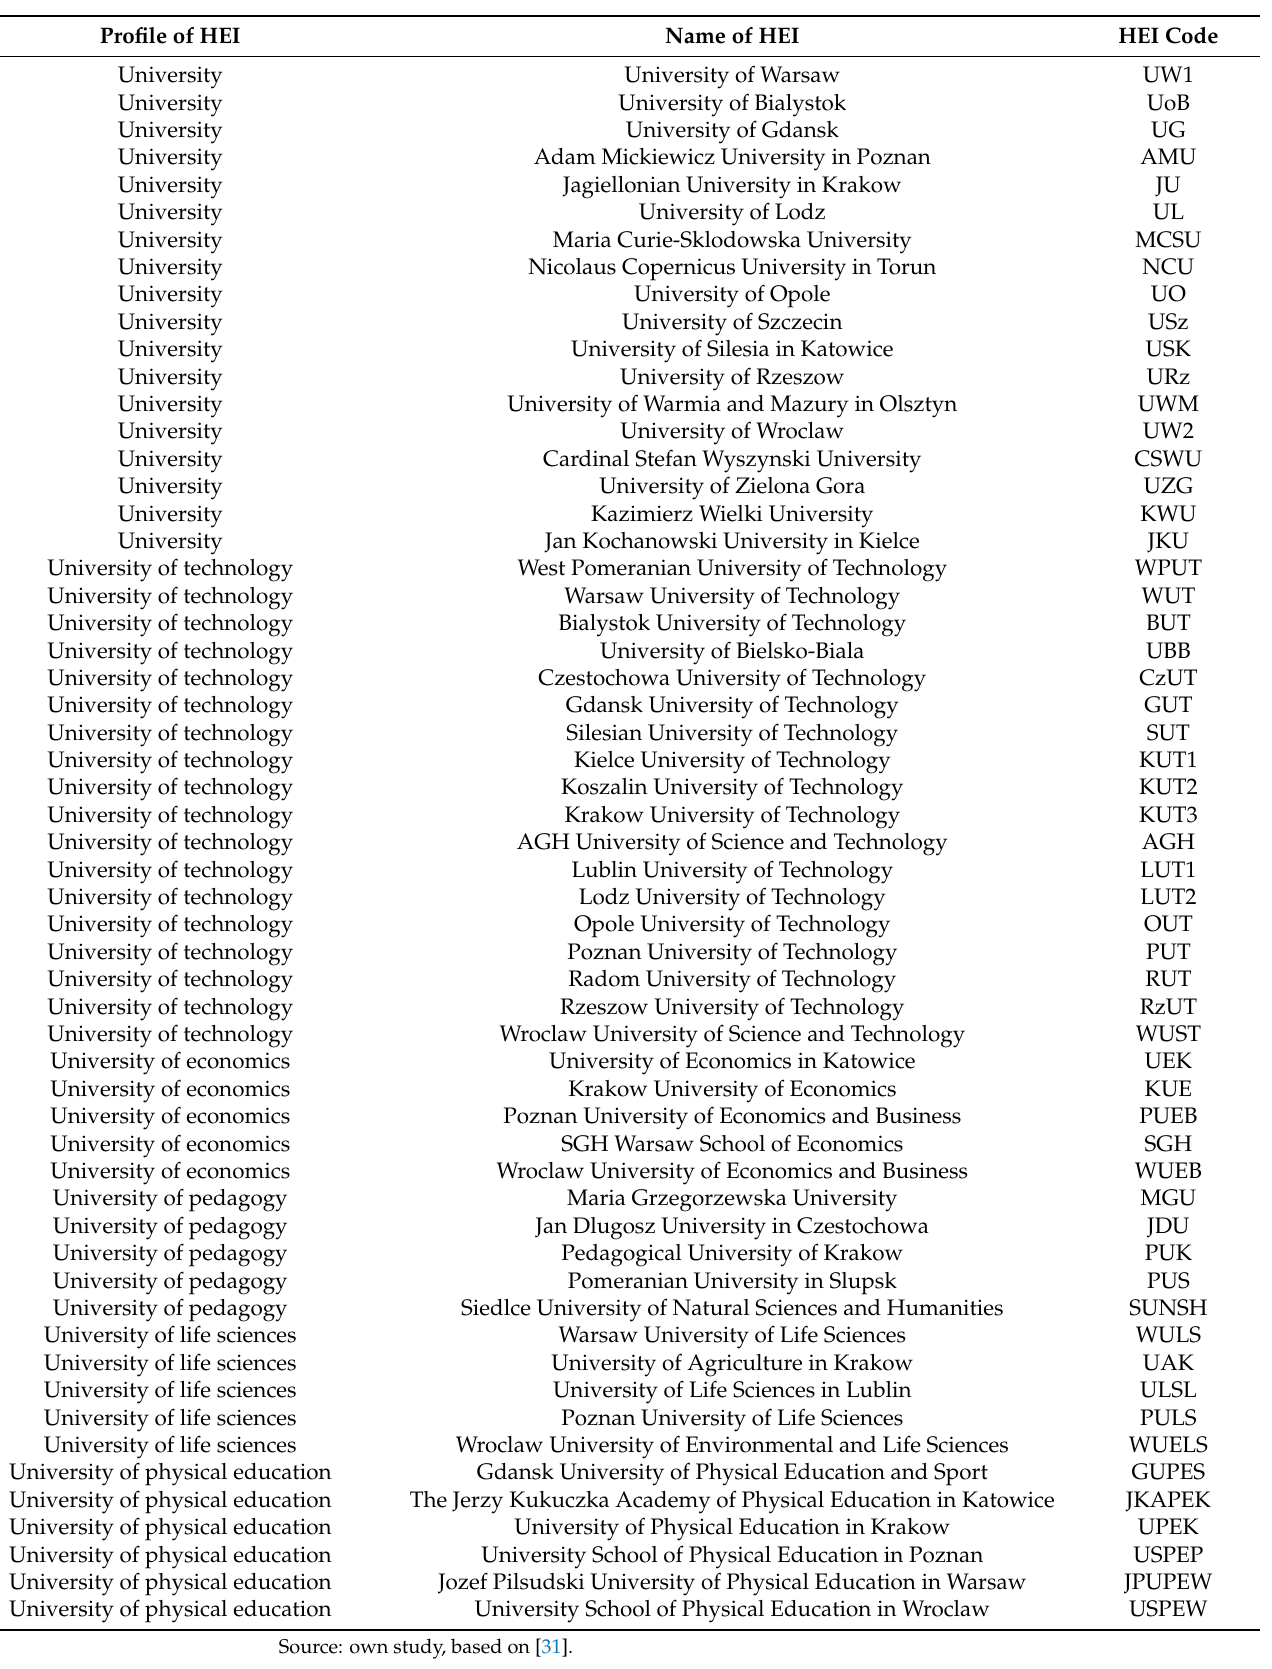
Table 2. HEIs included in the research sample with their